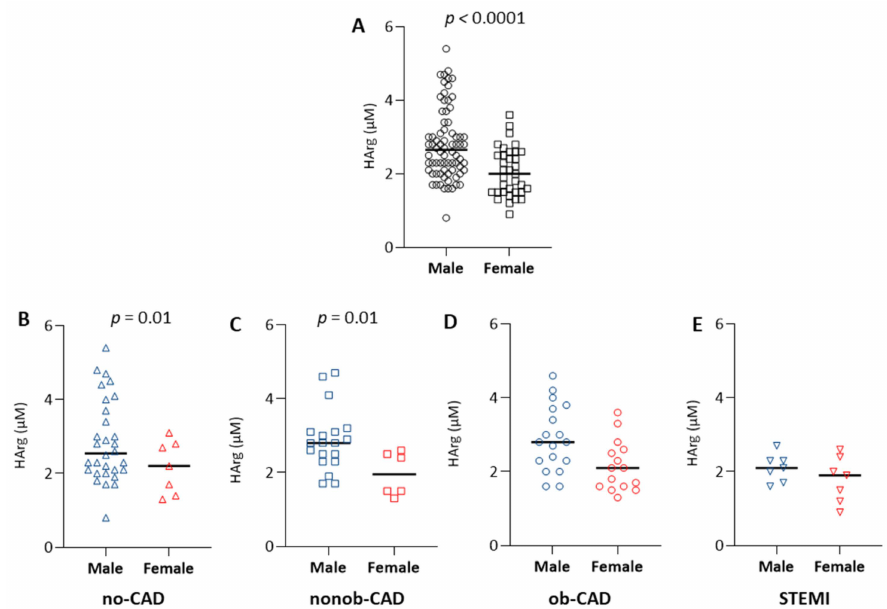
Figure 5. ( A ) Levels of HArg in plasma from male and female (raw data), independent of the disease condition. Levels of HArg in plasma from ( B ) no-CAD, ( (cid:52) ), ( C ) nonob-CAD ( (cid:3) ), ( D ) ob-CAD (o), and ( E ) STEMI ( (cid:53) ) patients, based on sex. Data are represented using a scatter dot plot; horizontal lines show the median